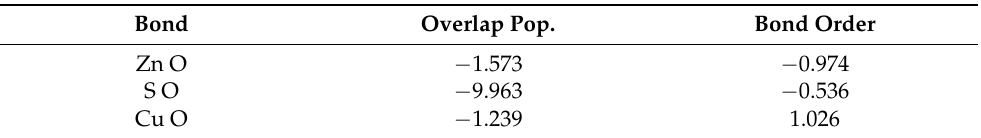
Table 2. Overlap population and bond order analysis for the proposed bonds in the SO 2 /Cu 2 Zn 10 O 12 complex. Bond Overlap Pop. Bond Order Zn O